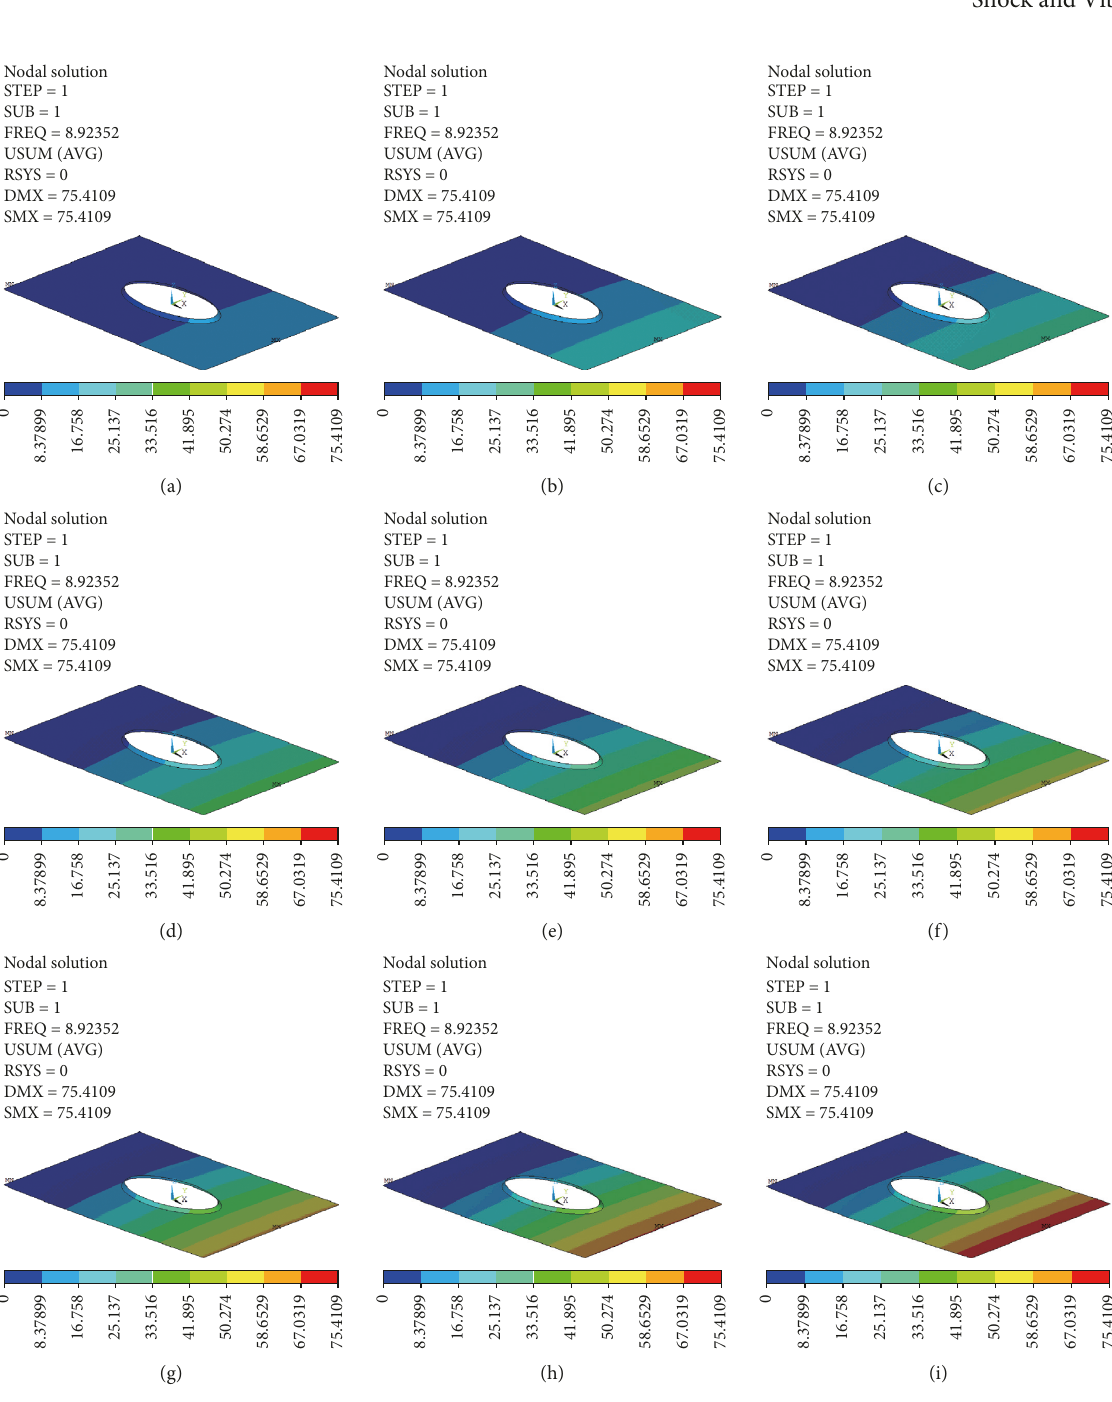
0.05. (b) Time (cid:31) (cid:31)